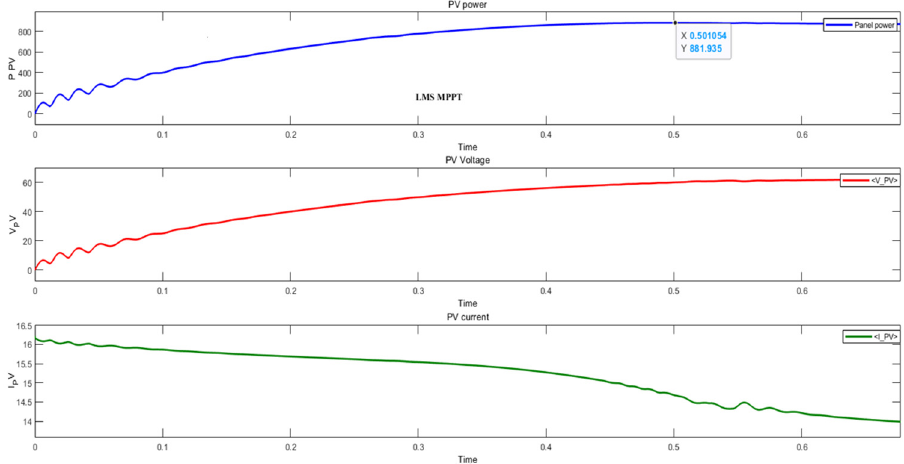
Figure 12. PV power, PV voltage and PV current responses of solar PV panel with the PSO MPPT controller under solar radiation = 1000 W/m2, T = 30 °C (deg. Celsius), load R = 100 ohms.